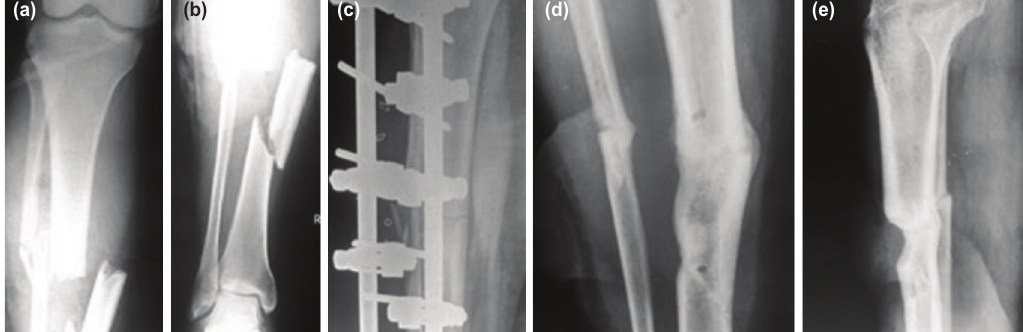
(a,b,c,d,e) Grade 3C open tibia fracture with injury to PTA managed by emergent debridement, skeletal fixation followed by Fig. 6: urgent vascular repair and LD free flap for wound coverage. Union was achieved with primary definitive external fixation in 42 weeks.